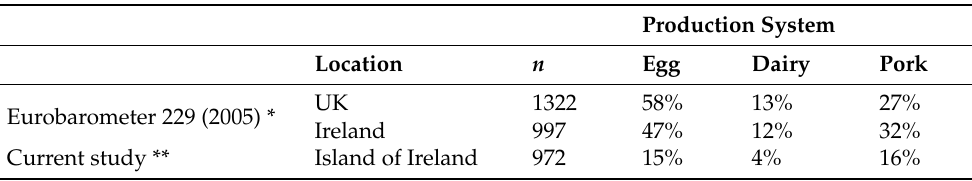
Table 7. Comparison of study findings with the Eurobarometer (2005) by combining negative response scores (*)